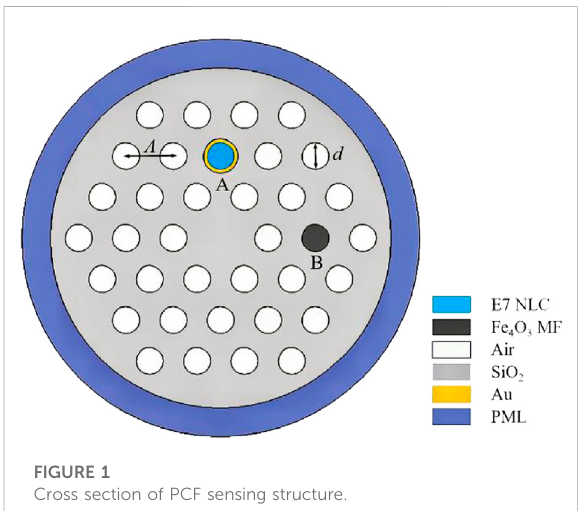
FIGURE 1 Cross section of PCF sensing